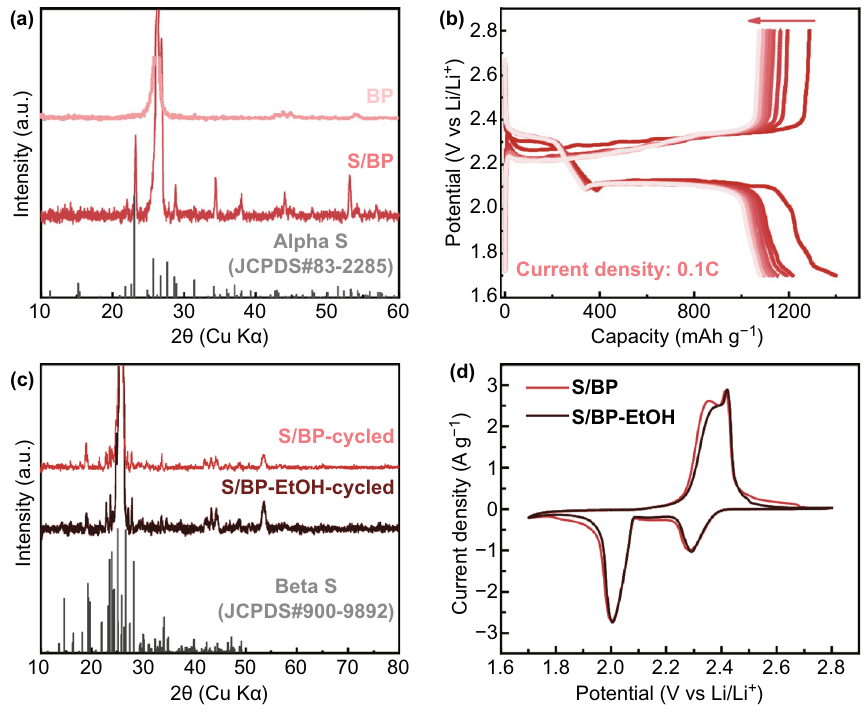
Fig. 2 a XRD pattern of S/BP. b Discharge–charge profile of S/BP at a rate of 0.1 C. c XRD patterns of S/BP and S/BP-EtOH after one cycle of charge–discharge. d CV of S/BP and S/BP-EtOH at 0.1 mV s